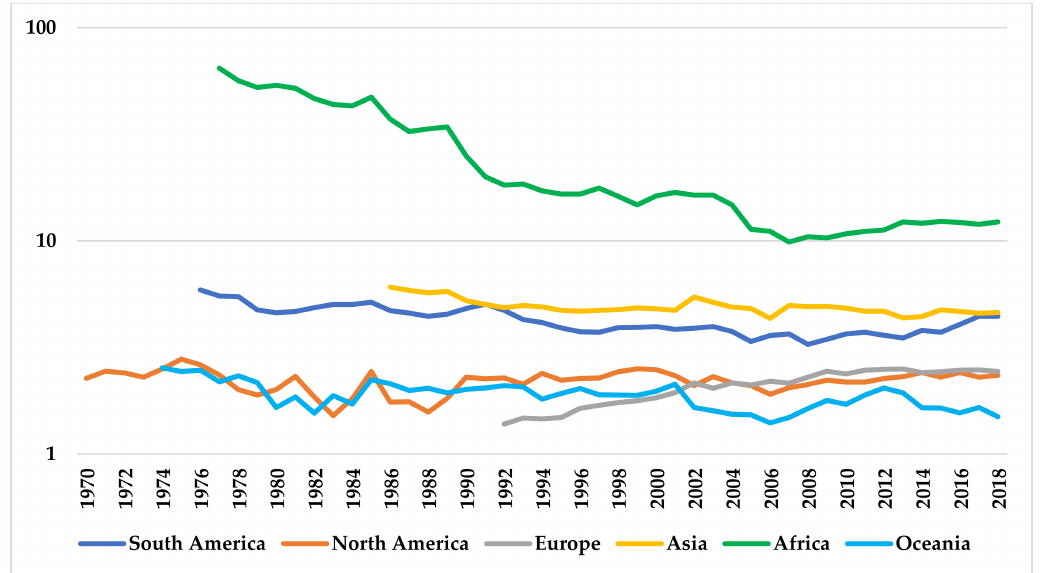
Figure 1. Energy return on investment (EdibleEROI) (kcal/kcal) (note logarithmic